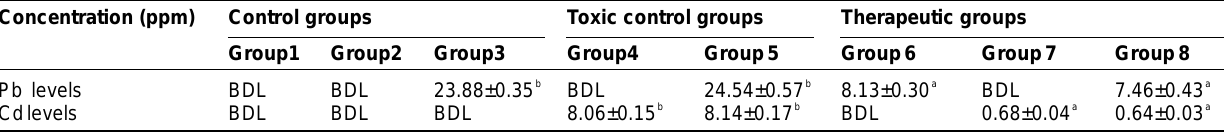
small alphabets are used for vertical comparison Table-2. Concentrations of Pb and Cd in different groups of rats. Concentration